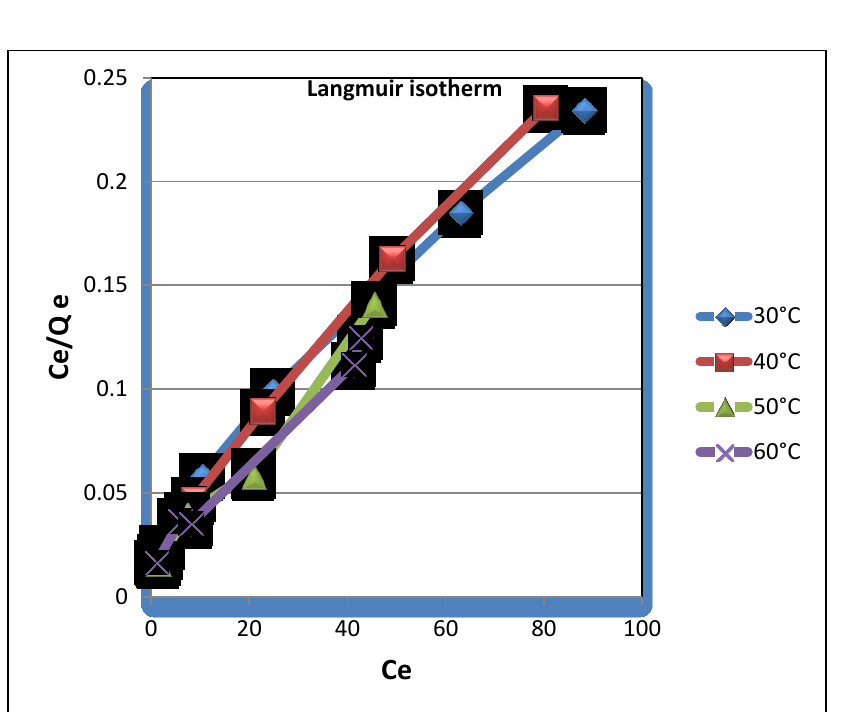
Figure 5. Langmuir Isotherm for the adsorption of malachite green onto